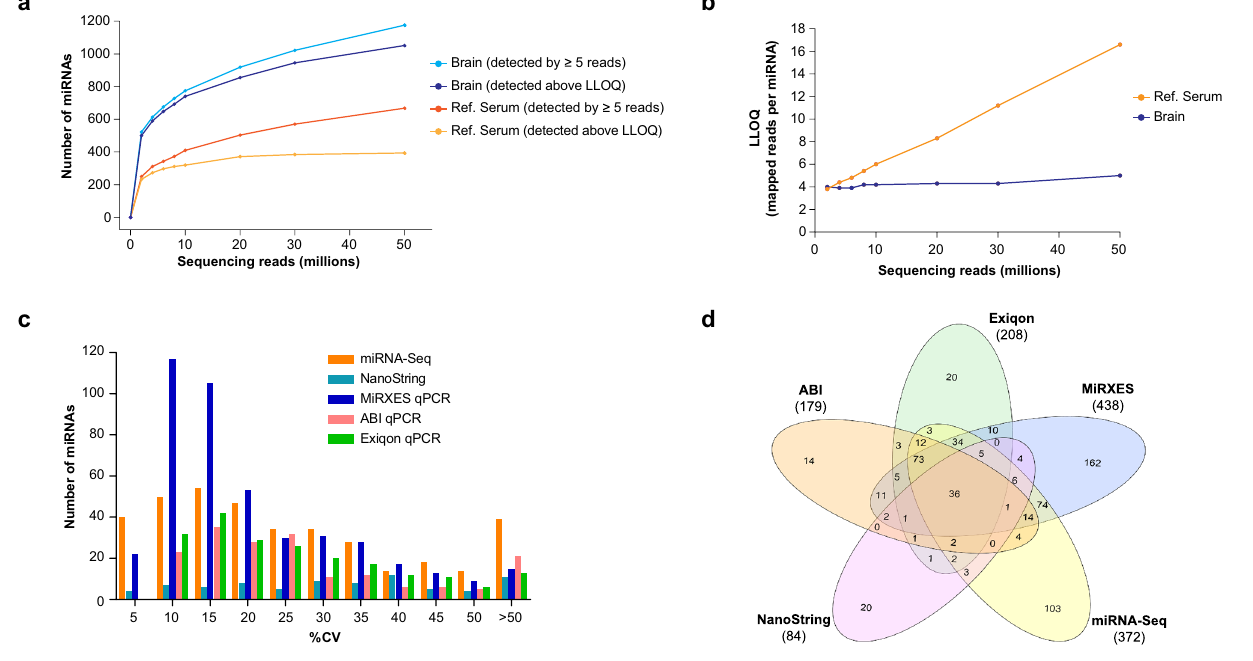
Figure 2. Detection rate, inter-platform overlap and LLOQ. ( a ) Detection rate of miRNAs as a function of sequencing depth for Brain QC and Ref. Serum miRNA-Seq libraries. ( b ) LLOQ of Brain QC and Ref. Serum miRNA-Seq libraries as a function of sequencing depth. LLOQ is expressed as the number of mapped reads per miRNA. ( c ) Coefficient of variation (%CV) observed in expression level for miRNAs detected above the LLOQ. ( d ) Overlap in miRNAs detected above LLOQ across